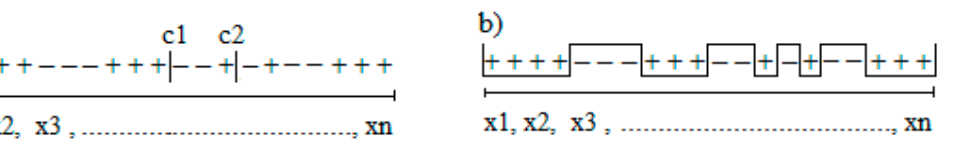
Figure 1. Decision boundary between positive (+) and negative ( − ) class of instances. Simple linear cutoff values (c1 and c2) defined in one-dimensional feature space ( a ) and nonlinear boundary defined by MLP neural network classifier ( b ).